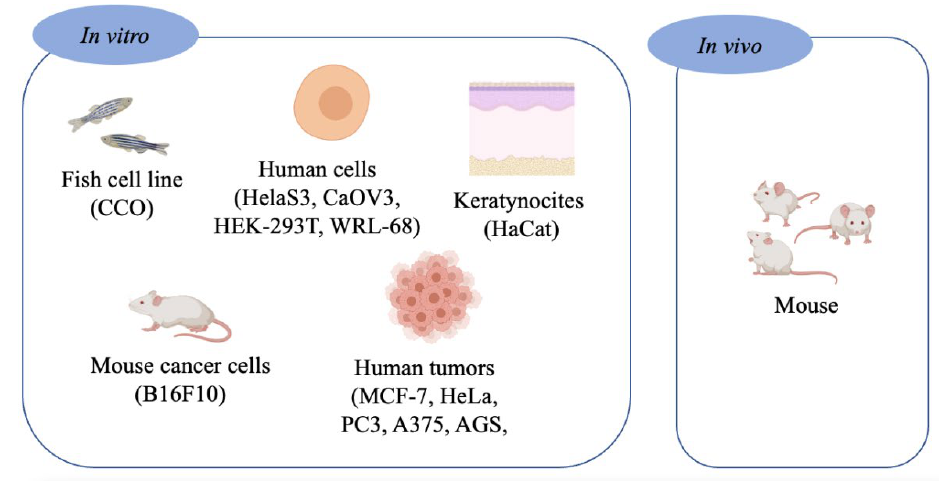
Figure 3. Most common in vitro and in vivo assays used in the determination of DES toxicity.